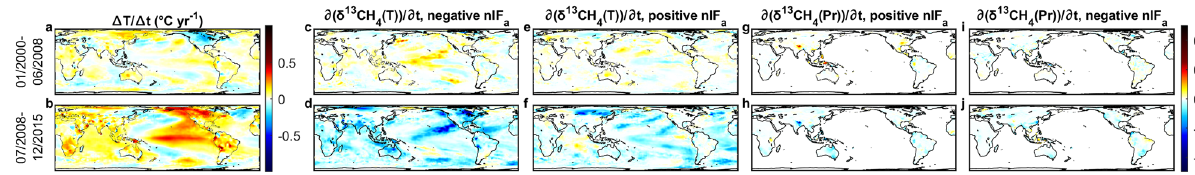
Fig. 5 Observed spatial distribution of temperature changes and estimated c- contributions to d ( δ 13 CH 4 ) /dt over different time periods. a, b Observed temperature change (°C yr − 1 ). c – j Estimated contributions ( ‰ yr − 1 ) from temperature ( c – f ) and precipitation ( g – j ) with negative ( c , d , i , j ) and